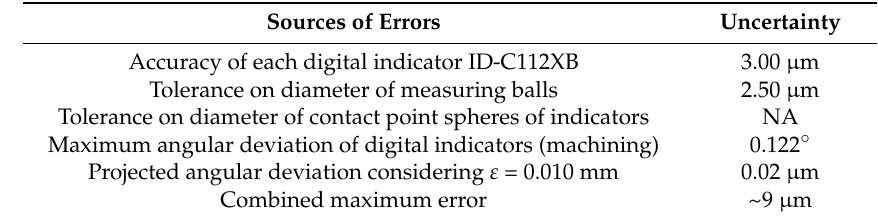
Table 1. Sources of errors of the measuring device.